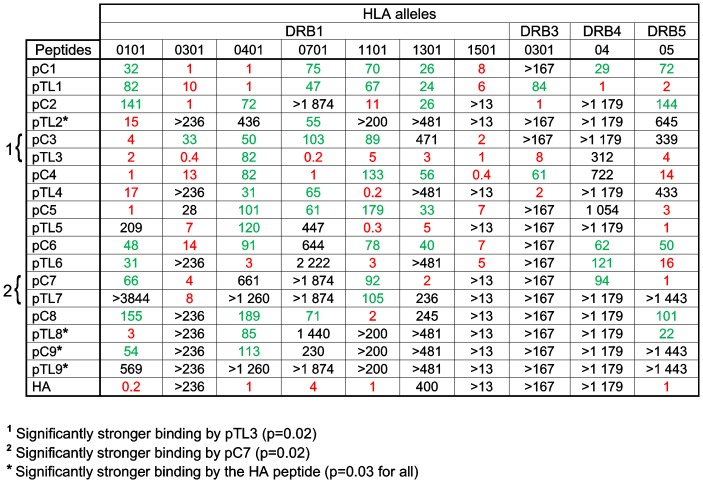
Binding capacities of the peptides pC1-pC9, pTL1-pTL9 and the HA peptide to HLA class II molecules.The binding capacities are expressed as relative binding ratios (IC50 of the test peptide divided by IC50 of the reference peptide) to take into account the differences in the sensitivity of the binding assays. The reference peptides exhibited the following IC50 values: DRB1*0101, 3 nM; DRB1*0301, 423 nM; DRB1*0401, 8 nM; DRB1*0701, 5 nM; DRB1*1101, 50 nM; DRB1*1301, 208 nM; DRB1*1501, 775 nM; DRB3, 60 nM; DRB4, 8 nM; DRB5, 7 nM. Values in red (IC50 ratio ≤20) are considered to indicate high affinity binding and values in green (IC50 ratio 20–200) moderate affinity binding.